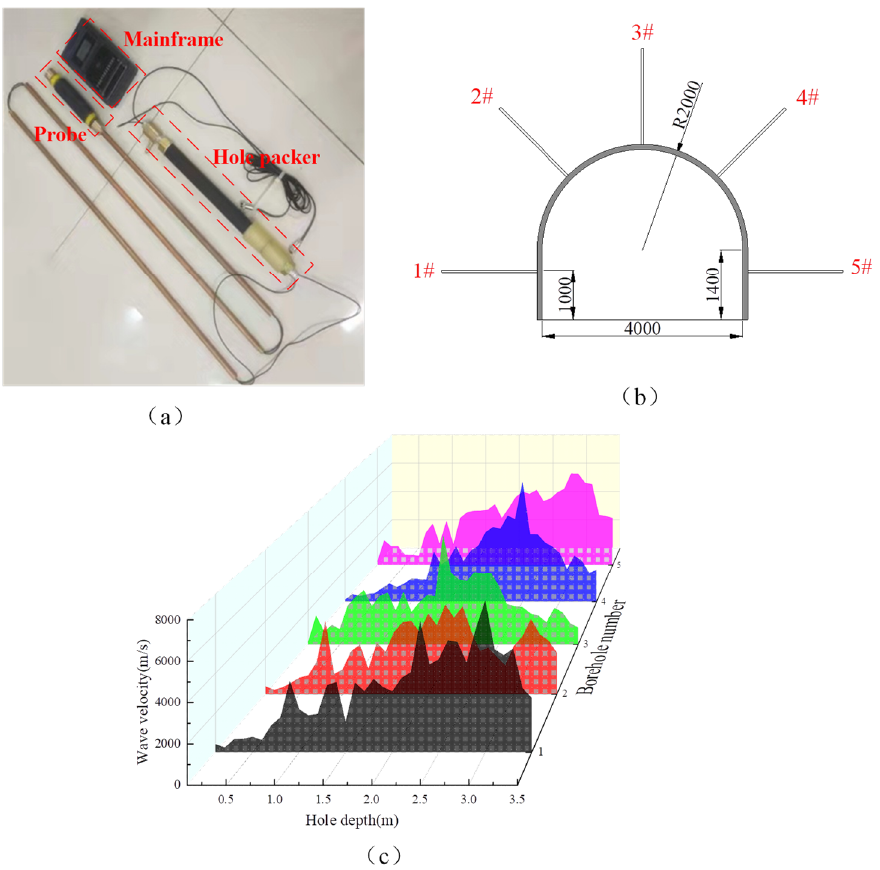
Figure 3. Surrounding rock loose circle test. ( a ) CT2 mine ultrasonic surrounding rock crack detector; ( b ) test borehole arrangement; ( c ) test results.